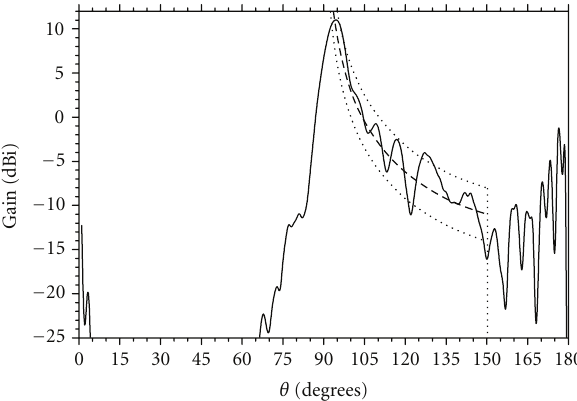
Figure 5: MoM radiation pattern in the elevation plane of the OADC antenna of Case II (solid line), together with the cosecant- squared pattern (dashed line) and its ± 3 dB limits (dotted lines).